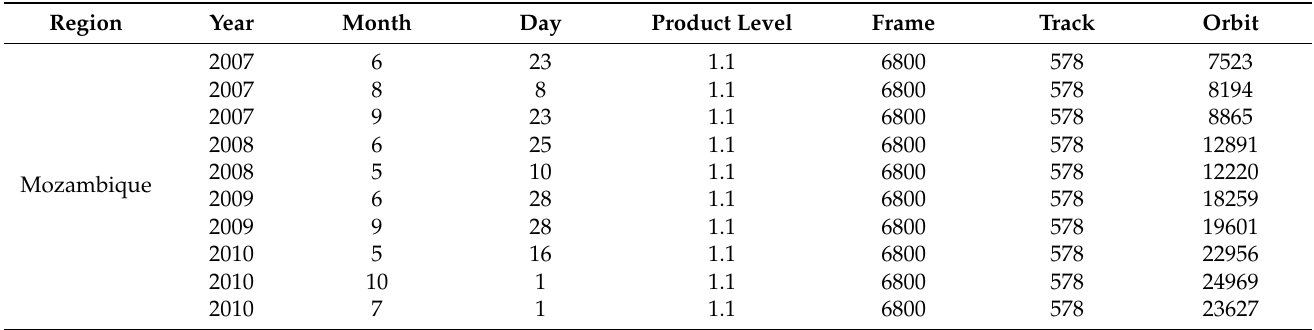
Table A1. Acquisition date, processing level, and metadata for each time step of ALOS PALSAR-1 imagery used in the model parameterisation.